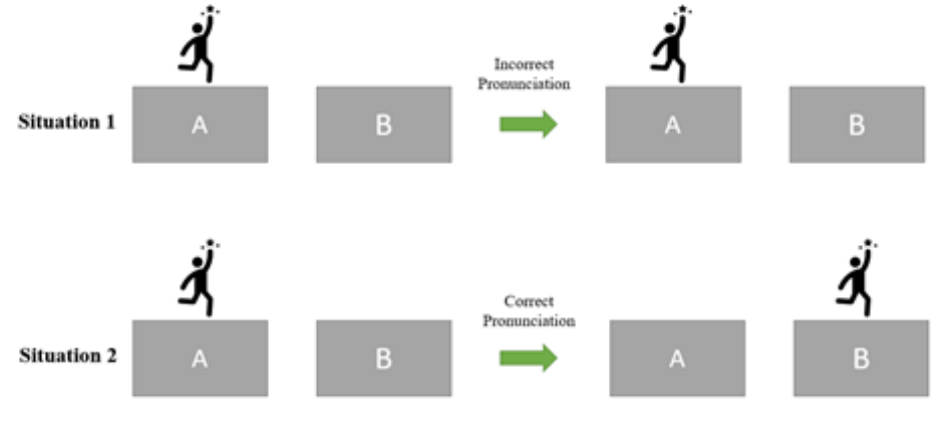
Figure 4. Representation of visual feedback.